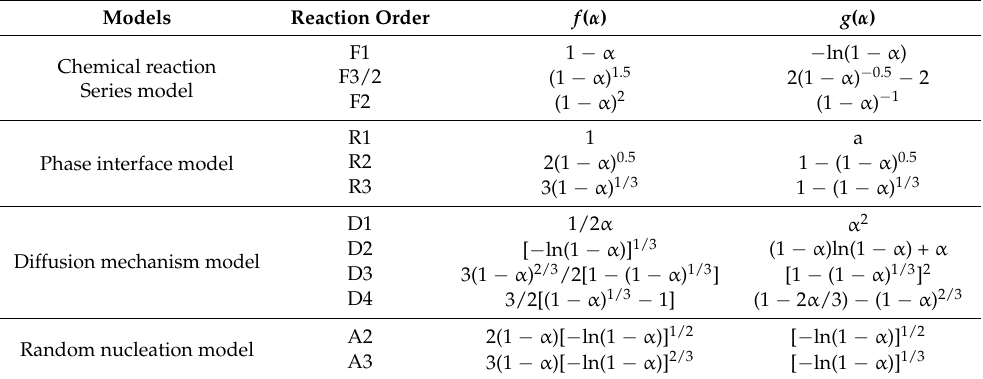
Table 2. Solid-state reaction kinetics